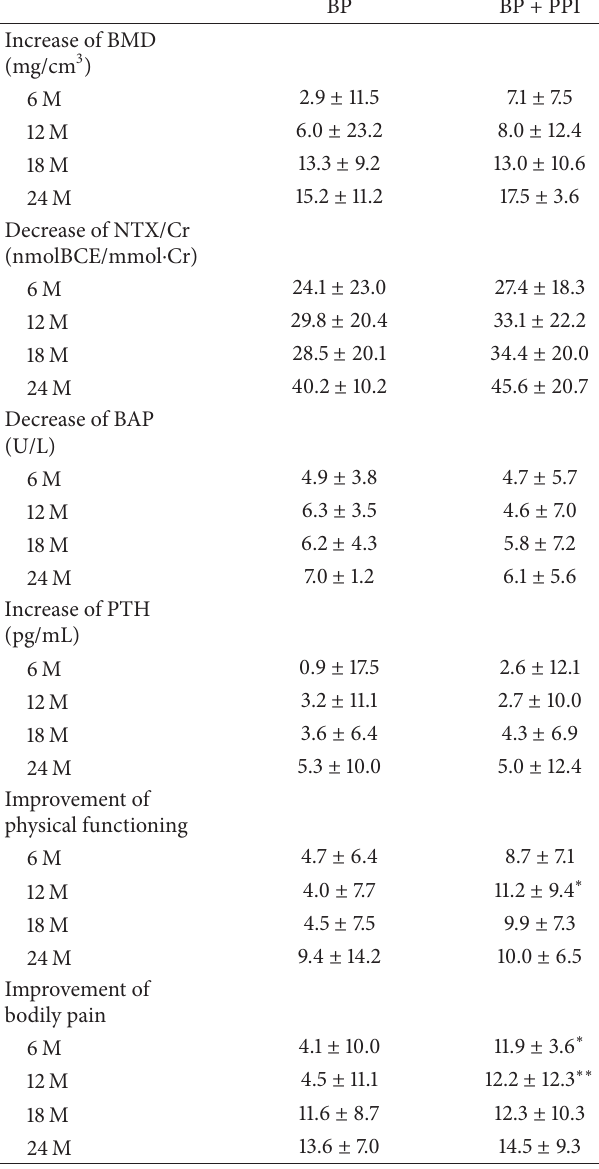
Table 3: The Δ value in BMD, NTX/Cr, BAP, PTH, and the physical